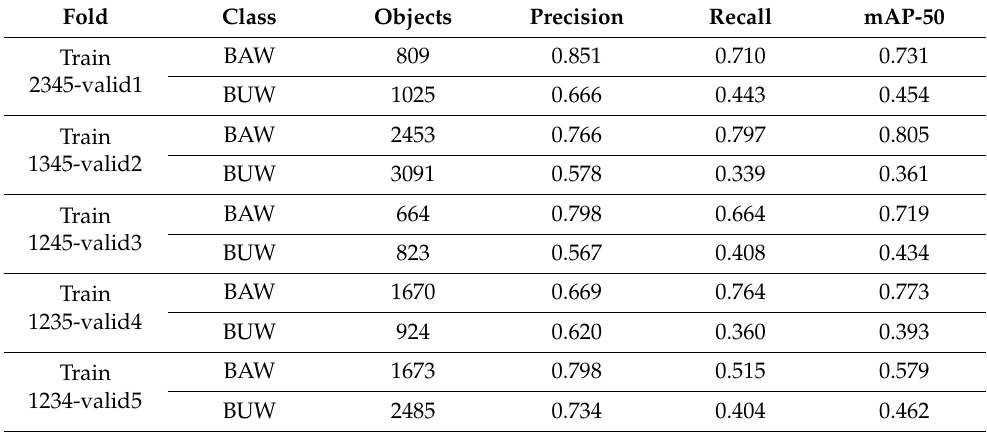
Table 4. The precision, recall, and mAP-50 for the validation